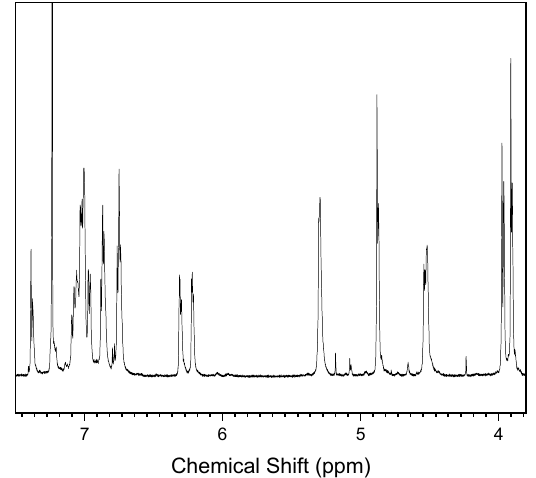
Figure 3. 1 H NMR spectrum of BAF-oda-fu.